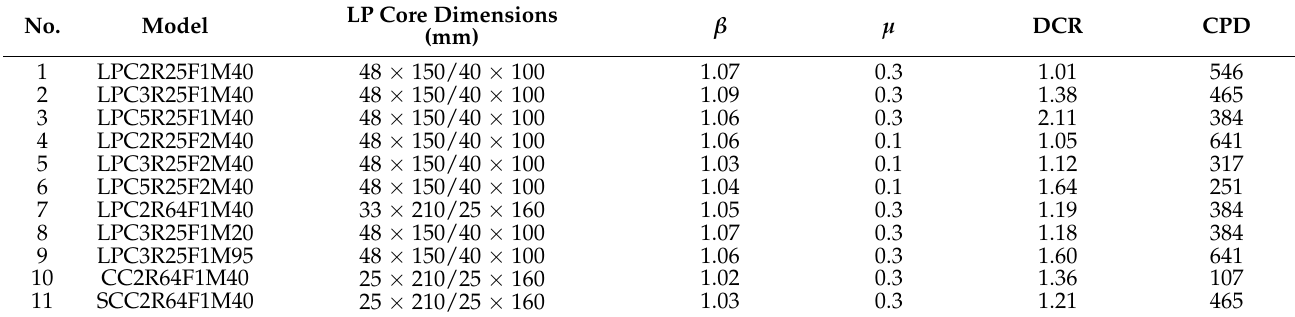
Table 4. The LPBRB numerical models’ seismic performance indices.